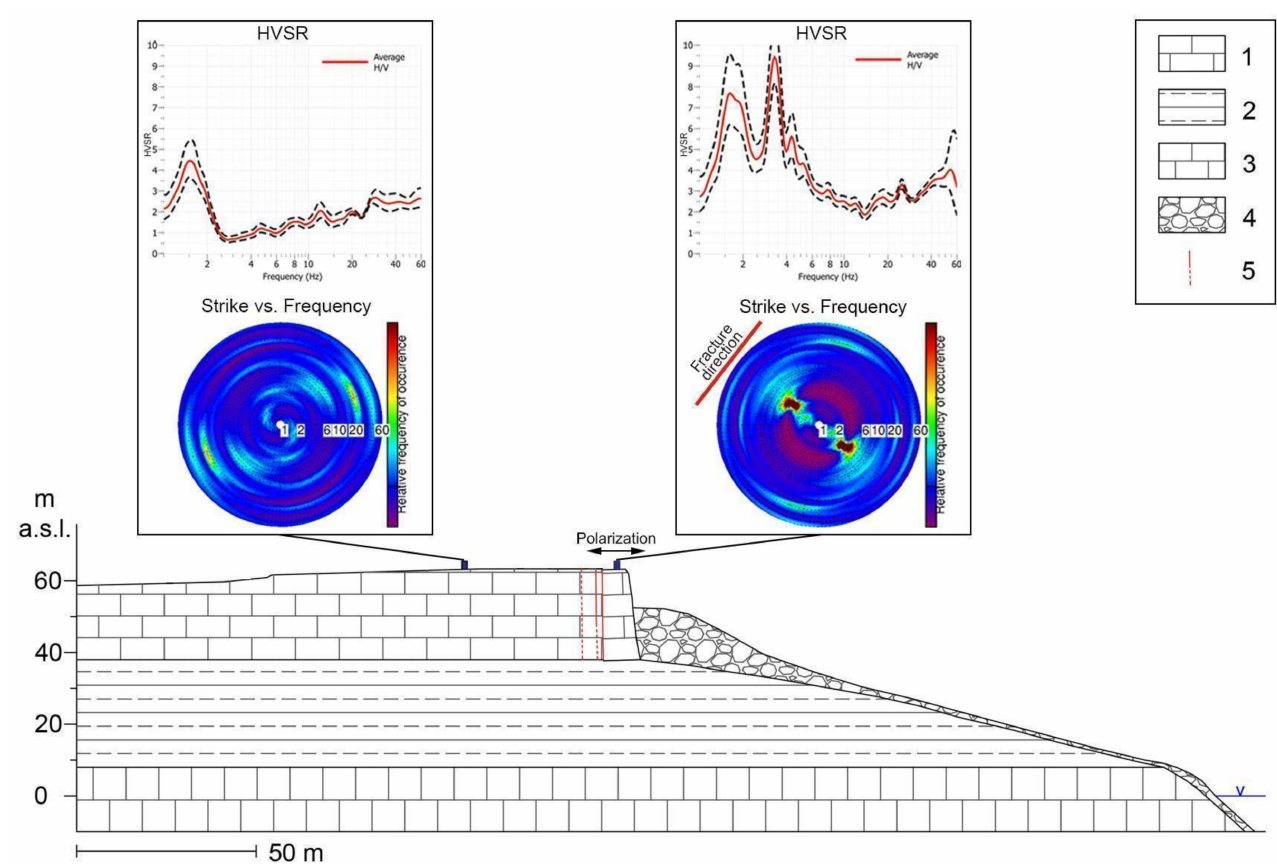
Figure 7. Example of HVSR and polarization analysis carried out on single station seismic ambient noise measurements at the Selmun Promontory (Malta, Central Mediterranean Sea) showing an HVSR peak with polarization roughly normal to the fracture direction, related to the main resonance frequency of an unstable rock block (modified after ref. [115], reproduced with the permission of Springer Nature, Journal of Seismology 2020). Legend: (1) Upper Coralline Limestone; (2) Blue Clay; (3) Globigerina Limestone; (4) debris slope deposit; (5) open joint (dashed where inferred). (v) Rock fragments and blocks: The presence of rock fragments in the landslide mass affects the water dynamics by creating pore-water pressure. The dimensions of these fragments can be delineated by other geophysical methods; these are bodies of